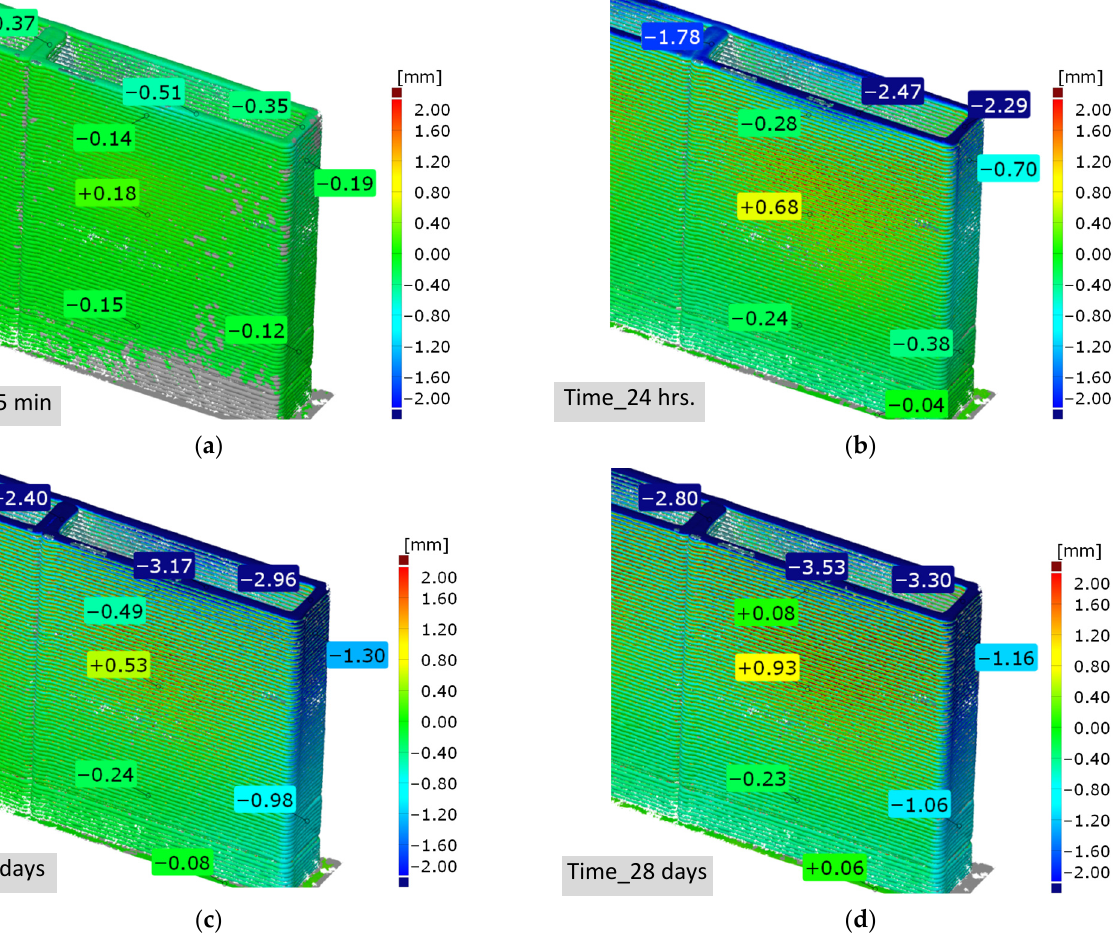
Figure 11. Color map showing deviations from reference sample ‘0 ′ ( a ) after 15 min; ( b ) after 24 h; ( c ) after 7 days; ( d ) after 28 days.